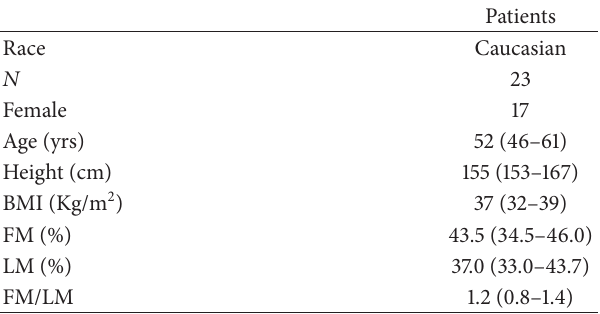
Table 1: Demographic and anthropometric features of obese patients at the